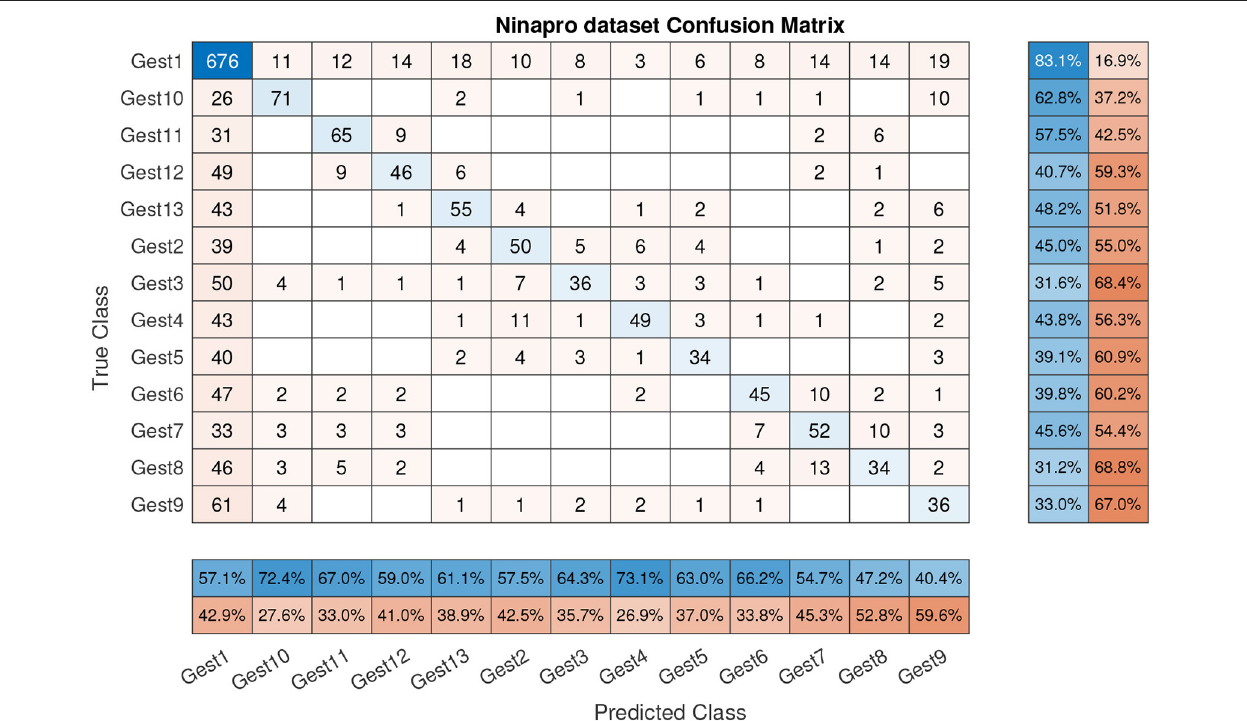
FIGURE 12 | Confusion matrix with NinaPro dataset (58.5%